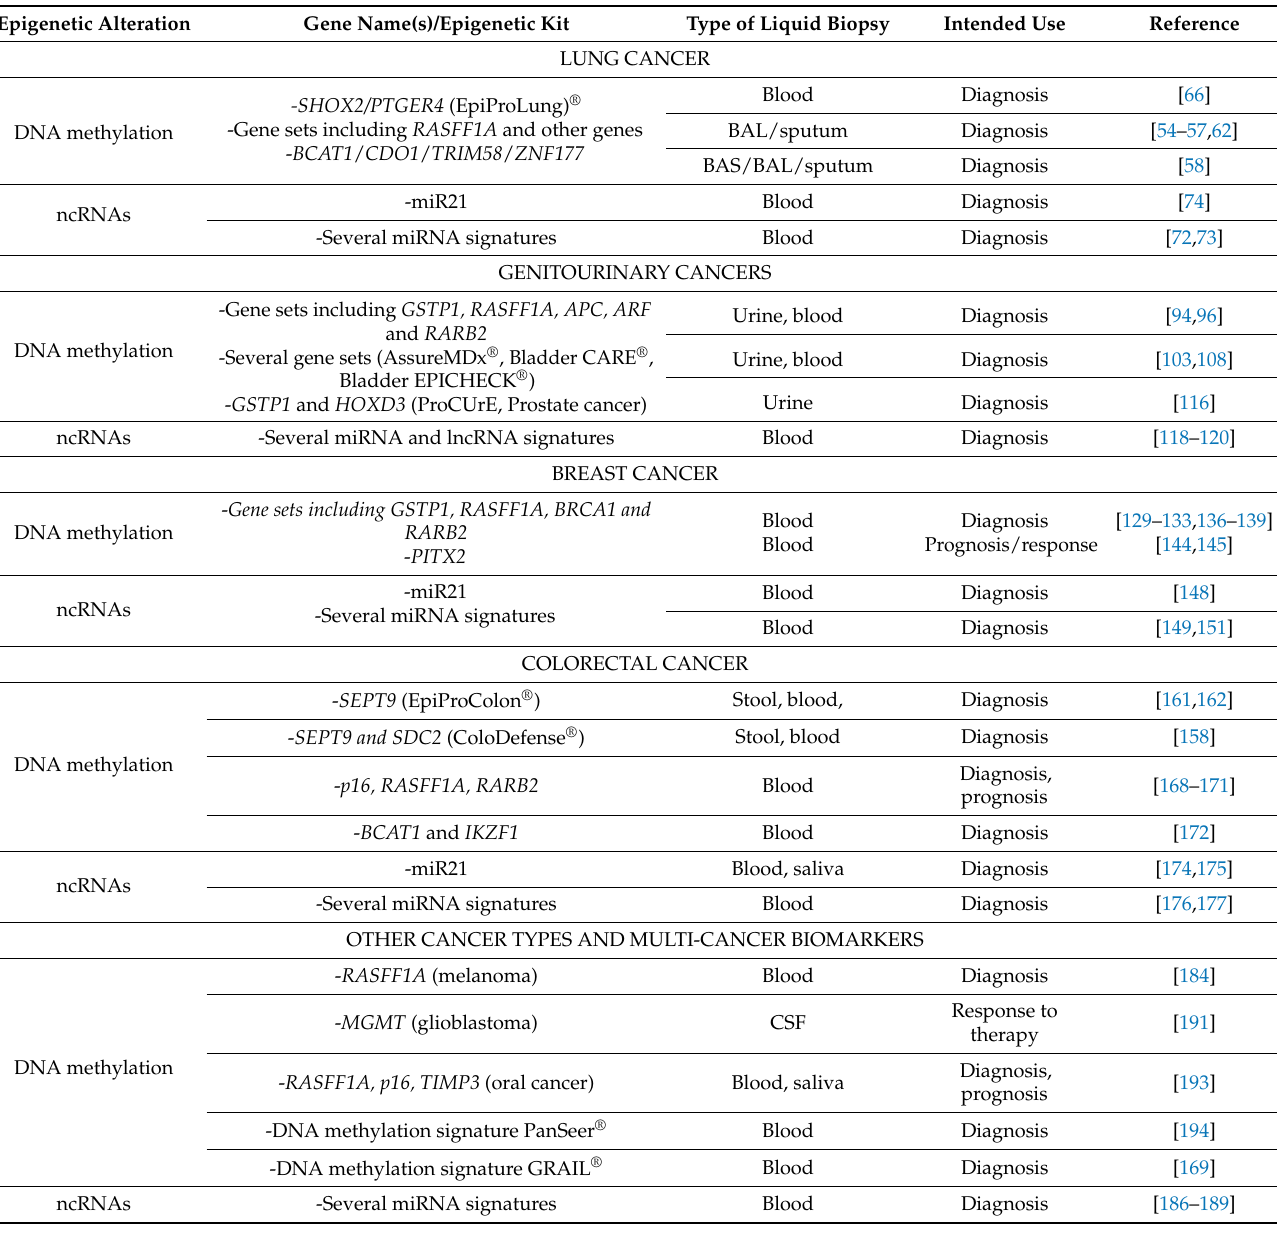
Table 1. Top methylated genes/signatures and ncRNAs identified in liquid biopsies from cancer patients, with an emerging role as biomarkers. BAL: bronchoalveolar lavage; BAS: bronchoalveolar aspirate; CSF: cerebrospinal fluid. Epigenetic